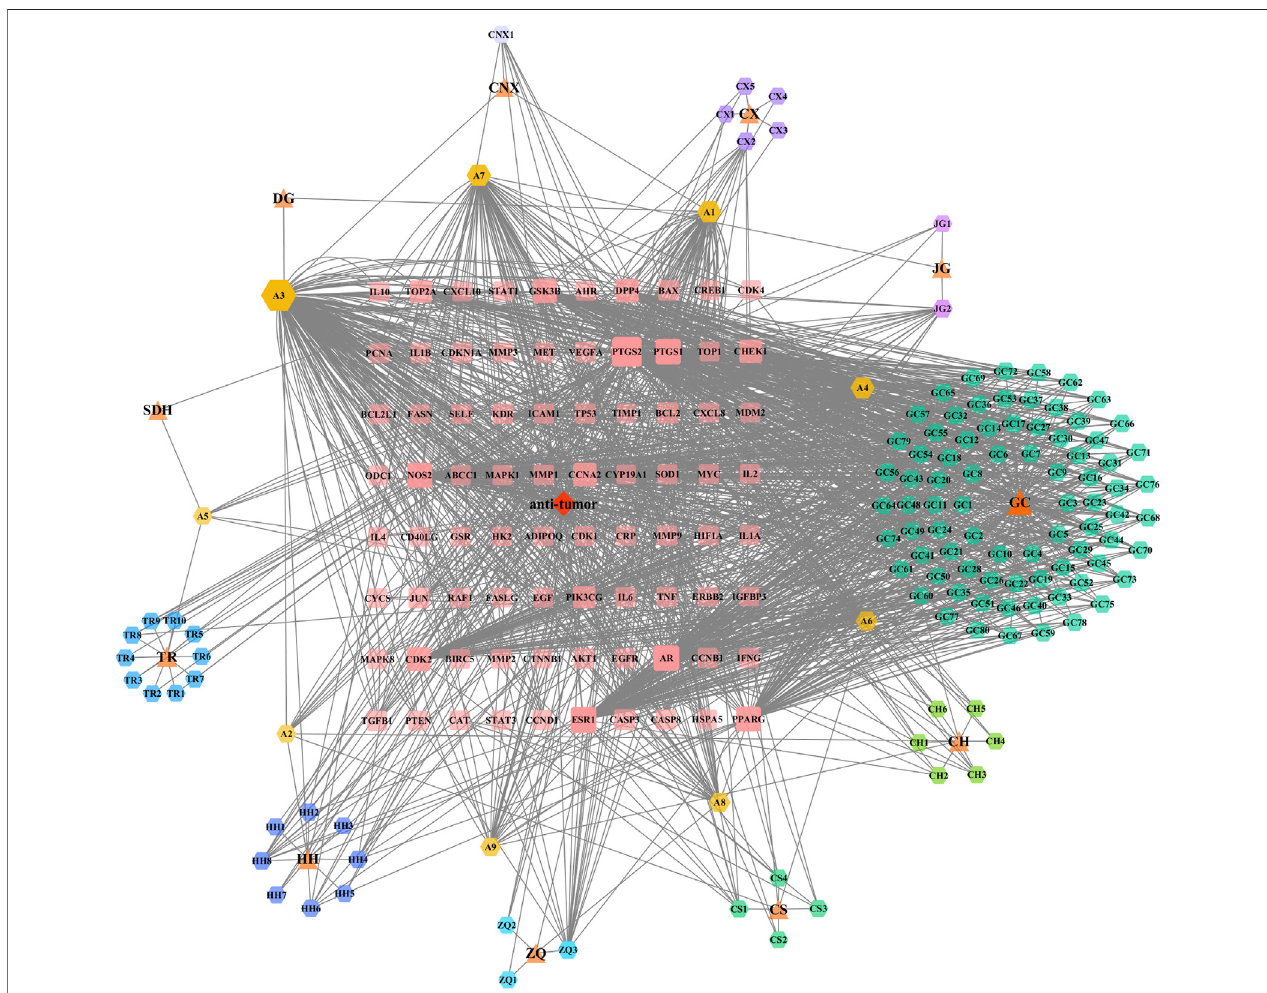
FIGURE 1 | Bioinformatic analysis of XFZYD ingredients. XFZYD anti-tumour related targets network comprises 11 herbs, 128 ingredients, and 80 targets. The herbs are presented as triangles, the ingredients as hexagons, and the targets as rounded rectangles. Node size and transparency were determined by the degree and value depicted as differences in size and colour